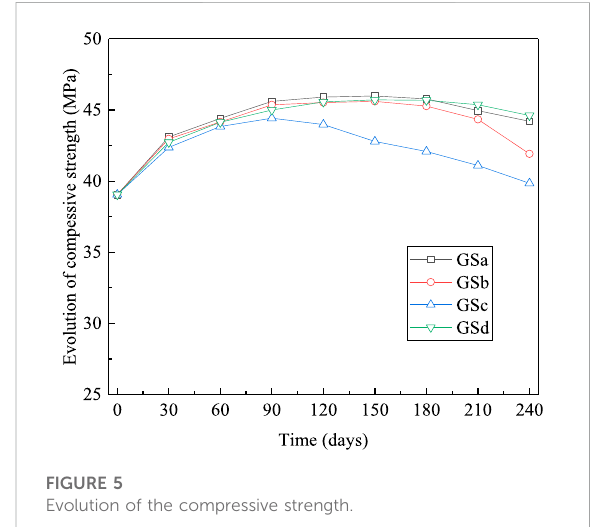
FIGURE 5 Evolution of the compressive